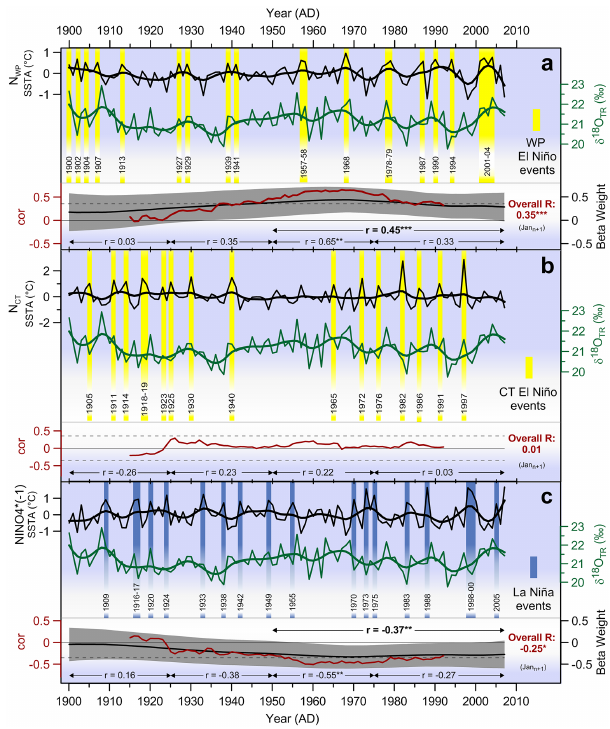
Figure 2. Time series of the δ 18 O TR chronology (green) and the January (Jan n + 1 ) indices of (a) Warm Pool ENSO ( N WP ), (b) Cold Tongue ENSO ( N CT ), and (c) negative NINO4 index (NINO4 × ( − 1), used here as a La Niña index. The WP and CT ENSO indices are computed as per Ren and Jin (2011) (Eq. 1). Thick lines denote 10-year cubic smoothing spline. In the lower part of each figure the running 31-year correlation (red) is shown. Dashed horizontal line indicates the 95% confidence level. Also shown are the results from a Kalman filter analysis (black line) used as a dynamic regression-modeling tool. Gray shading denotes ± 2 standard error limits of the beta weights. Where the limits do not cross zero, the regression relationship is considered statistically sig- nificant ( p = 95%). ENSO events based on classification of Table 1 are highlighted in yellow (El Niño) and blue (La Niña), respectively. ( ∗∗∗ p < 0 . 001, ∗∗ p < 0 . 01, ∗ p < 0 .